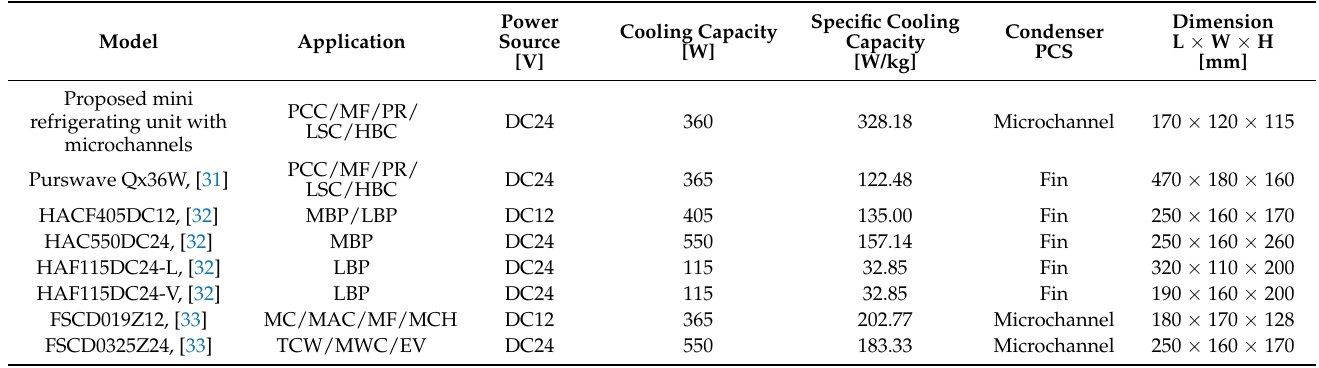
Table 6. Mini refrigeration